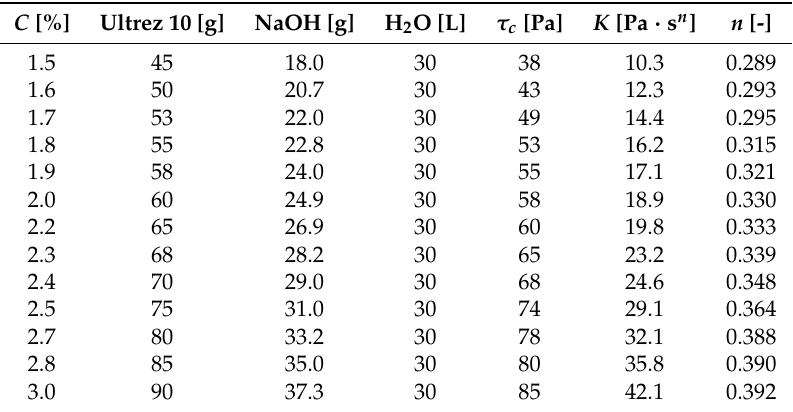
Table 1. Rheological characteristics of the Carbopol used in the present study. C [%] Ultrez 10 [g] NaOH